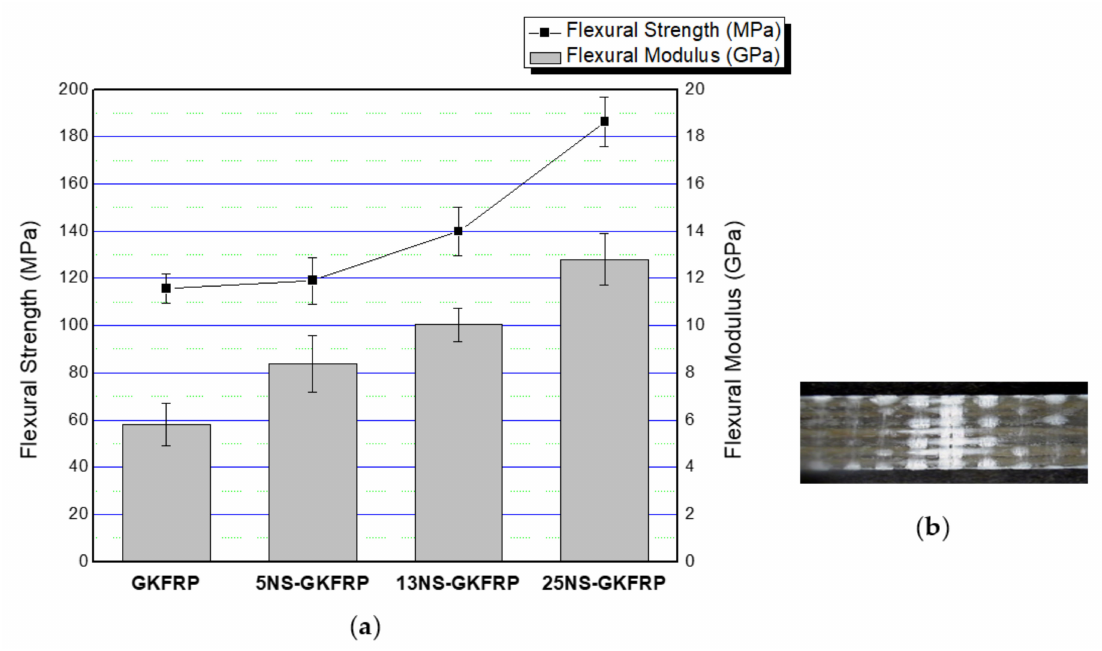
Figure 8. ( a ) Flexural properties of nanosilica-modified GKFRP (5NS-GKFRP, 13NS-GKFRP and 25NS-GKFRP) compared with GKFRP. ( b ) Example of fractured GKFRP samples after flexural